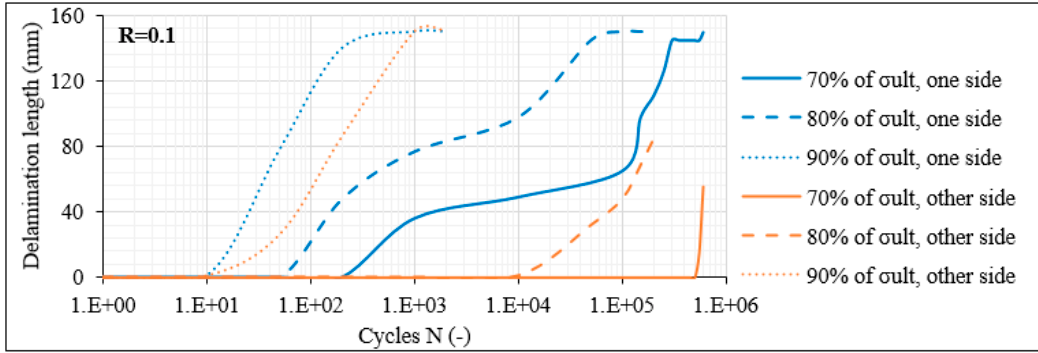
Figure 13. Matrix crack density versus N in [0°/60°/ − 60°] 2s laminates for R = 0.1. Figure 14. Delamination crack growth versus N in [0°/60°/ − 60°] 2s laminates for R = 0.1.